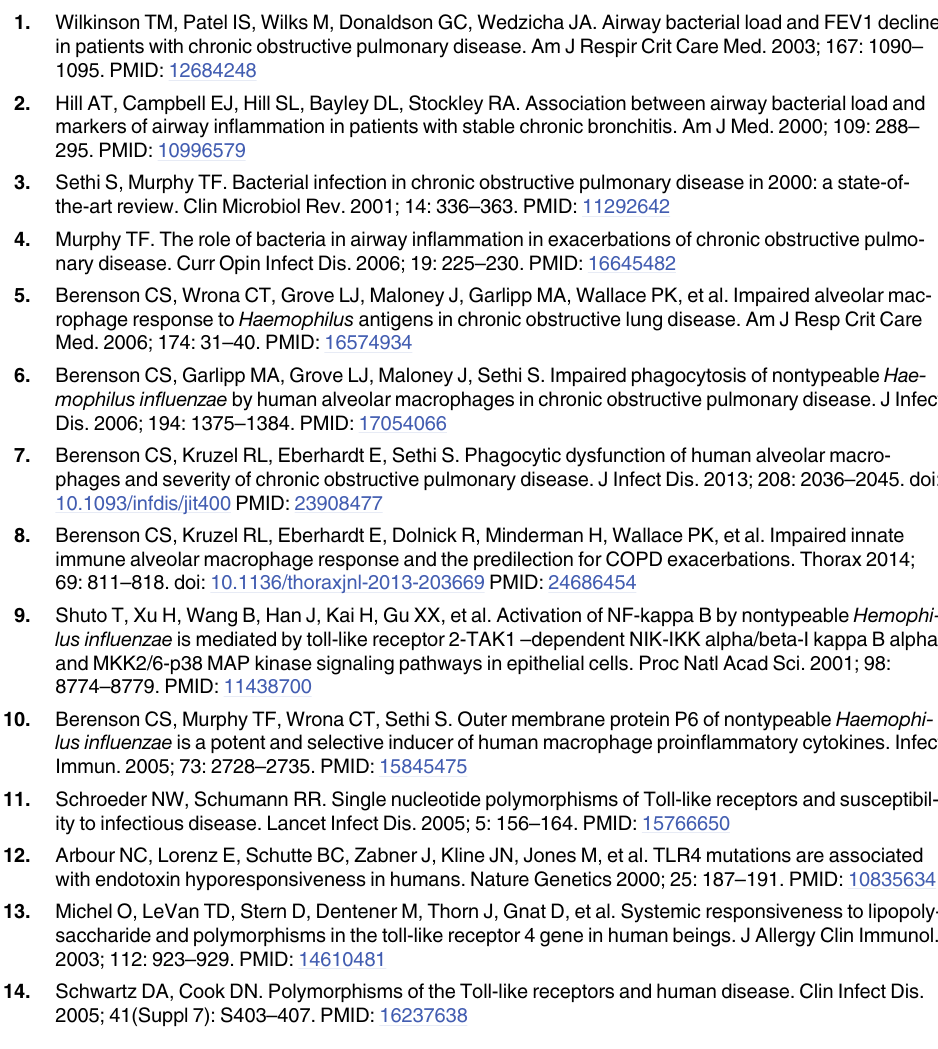
S6 Table. Alveolar macrophage log expressing wildtype (w/t), TLR9 (T1237C) and TLR9 (T1486C).